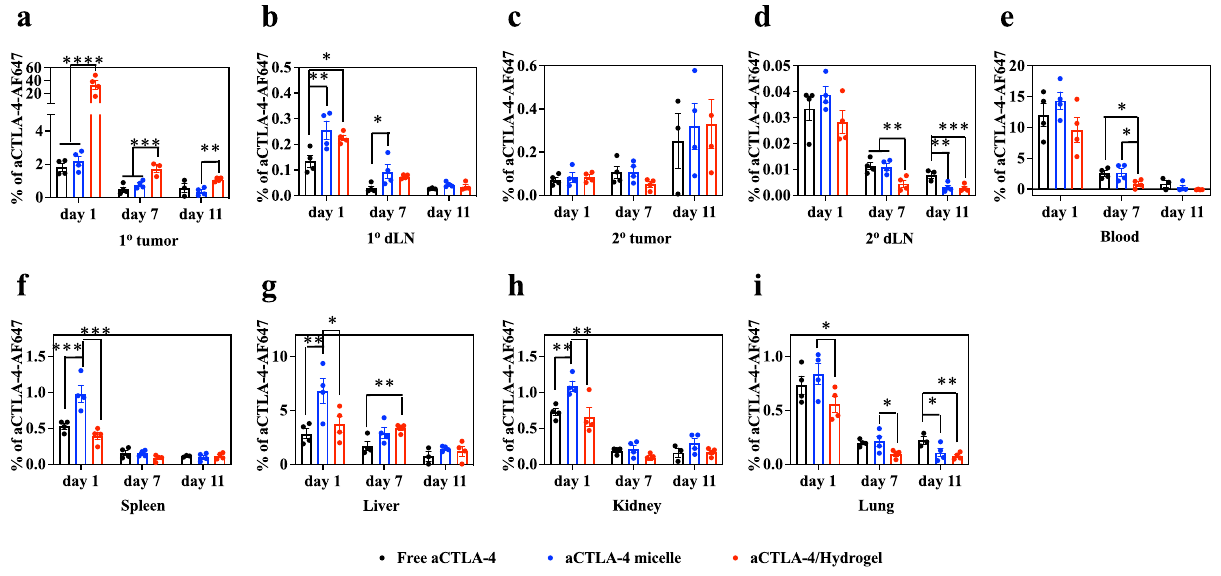
Fig. 5 In vivo biodistribution of aCTLA-4 released from F127- g -Gelatin thermosensitive hydrogels. a – i Biodistribution of free aCTLA-4-AF647, aCTLA- 4-AF647 with 0.45 wt.% F127-g-Gelatin micelles (aCTLA-4 micelle), and aCTLA-4-AF647 with 4.5 wt.% F127- g -Gelatin hydrogel (aCTLA-4 dose equivalent to 162 µ g mouse − 1 ) administered into the 1 o tumor of C57Bl/6 mice bearing 1 o and 2 o tumors inoculated with B16F10-OVA 10 5 cells in 30 μ L saline on day 0 and day 4, respectively. a 1 o (directly injected) tumor; b LN draining the 1 o tumor (1 o dLN); c 2 o (uninjected) tumor; d LN draining the 2 o tumor (2 o dLN); e blood; f spleen; g liver; h kidney; i lung. Data are presented as mean ± SEM. n = 4 except ( a-i ) Free aCTLA-4 groups on day 11 ( n = 3) and ( a ) aCTLA-4/Hydrogel on day 7 ( n = 3). *****p < 0.0001, ****p < 0.001, ***p < 0.01, **p < 0.05, and *p < 0.1 with one-way ANOVA using Tukey post-hoc statistical hypothesis. Exact p -values for a – i are reported in Supplementary Table 7. Source data are available in a Source Data fi